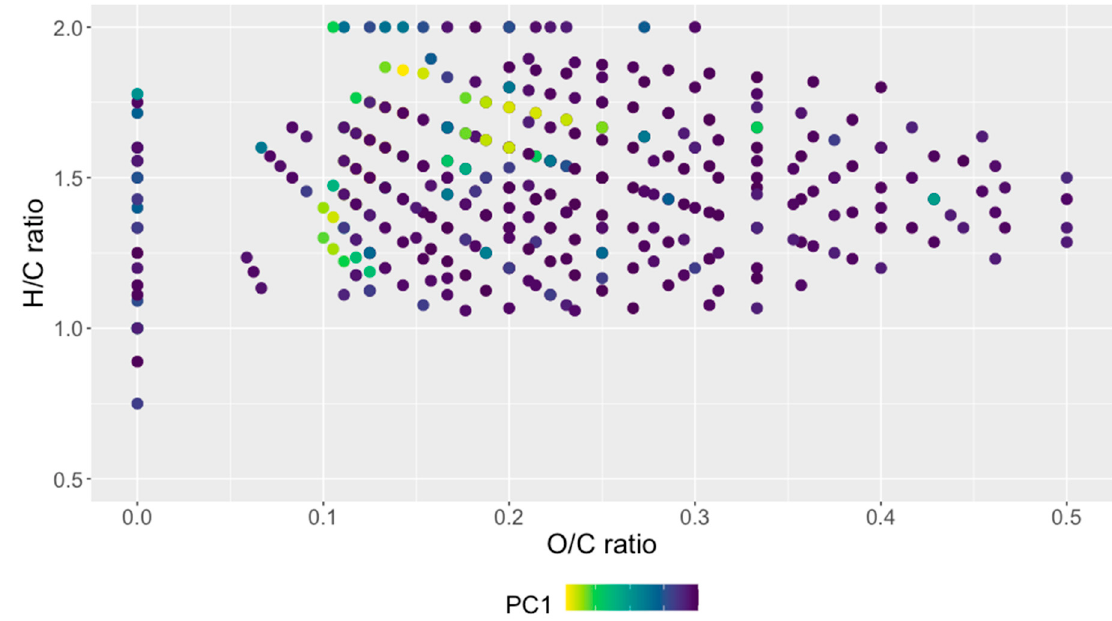
Figure 3. A van Krevelen plot of all formulae used to calculate sample distribution in the previous PCA (Figure 1). Formulae are colour-coded according to factor loadings according to PC1.